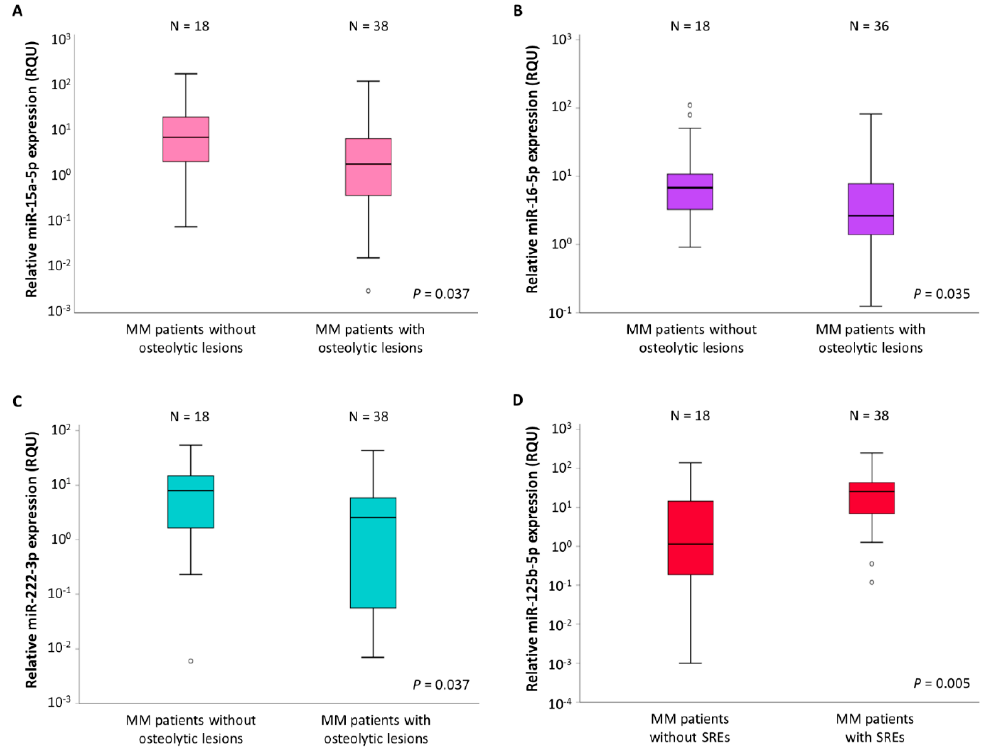
Figure 3. Boxplots showing the relative expression of miR-15a-5p ( A ), miR-16-5p ( B ), and miR-222-3p ( C ) in CD138+ plasma cells of multiple myeloma (MM) patients without and with osteolytic lesions. ( D ) Boxplot showing the relative expression of miR-125b-5p in CD138+ plasma cells of MM patients without and with skeletal-related events (SREs). The bold line inside each box represents the median value, while the lower and upper borders of the box represent the 25th (Q1) and 75th (Q3) percentiles, respectively; the area within the box represents the interquartile range (IQR). The lower and upper whiskers show values equal to Q 1 − 1.5 ∗ IQR and Q 3 + 1.5 ∗ IQR , respectively. The circles outside boxes indicate outliers. The scale of the vertical axis is logarithmic.